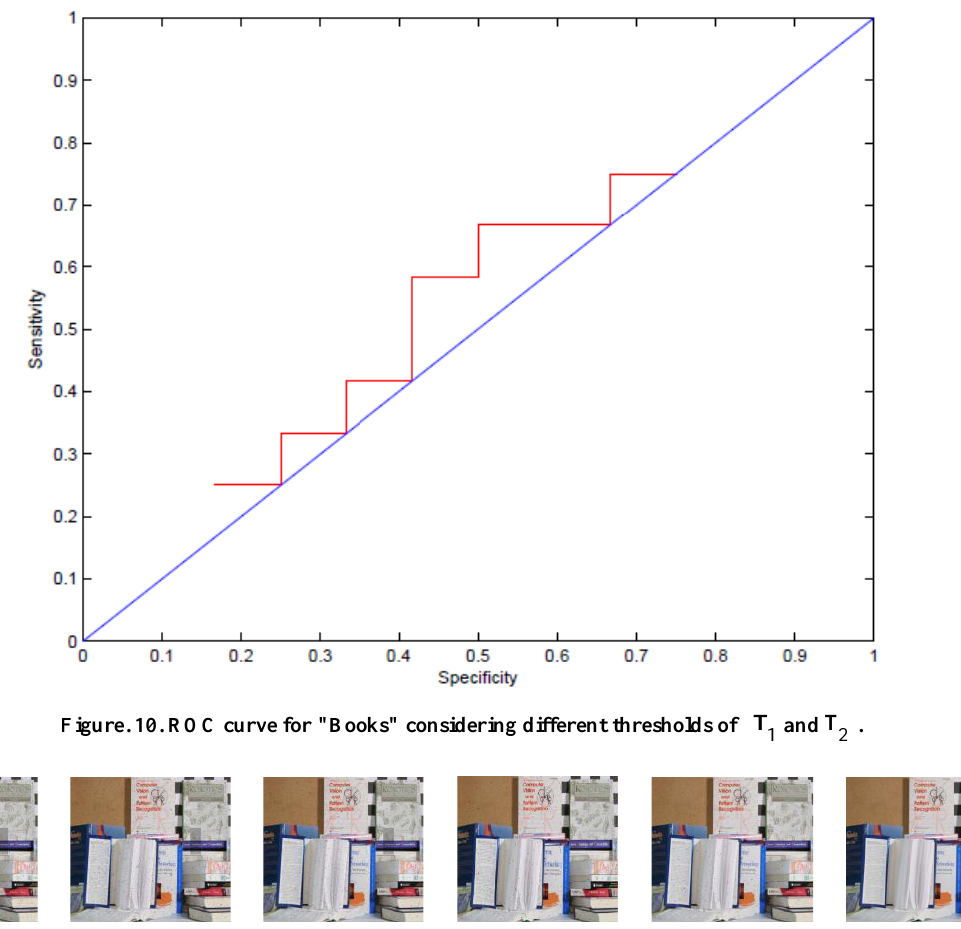
T =8.6 , T =7 , T =5.4 (f) ground truth. 1 3 2